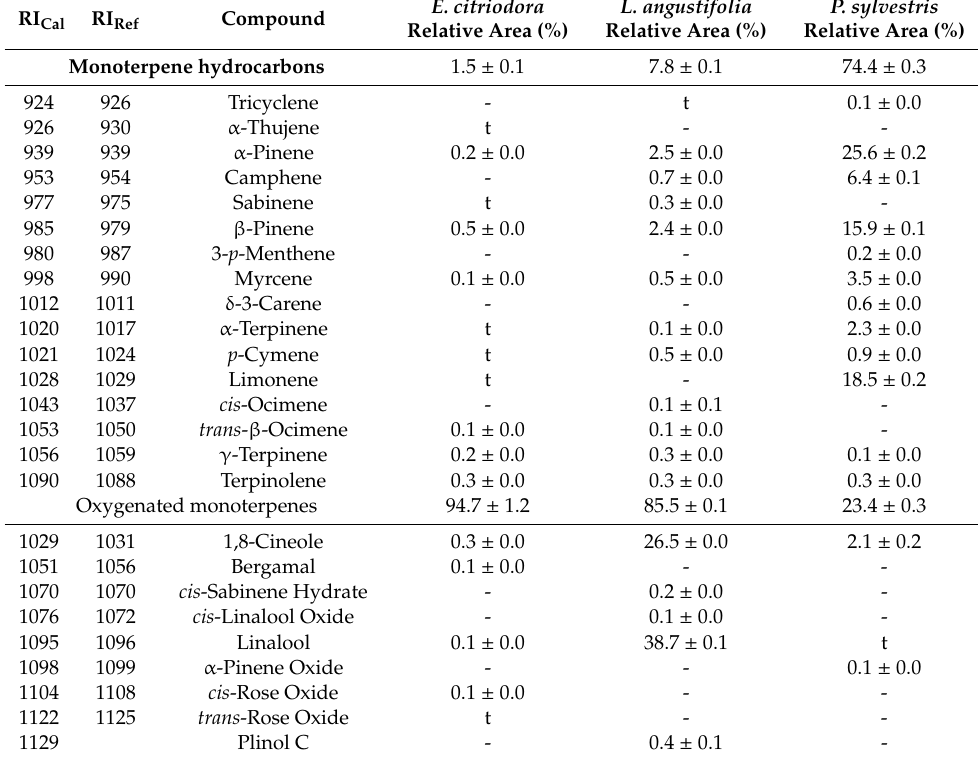
Table 1. Chemical compositions of commercial E. citriodora , L. angustifolia , and P. sylvestris essential oils. RI Cal RI Ref